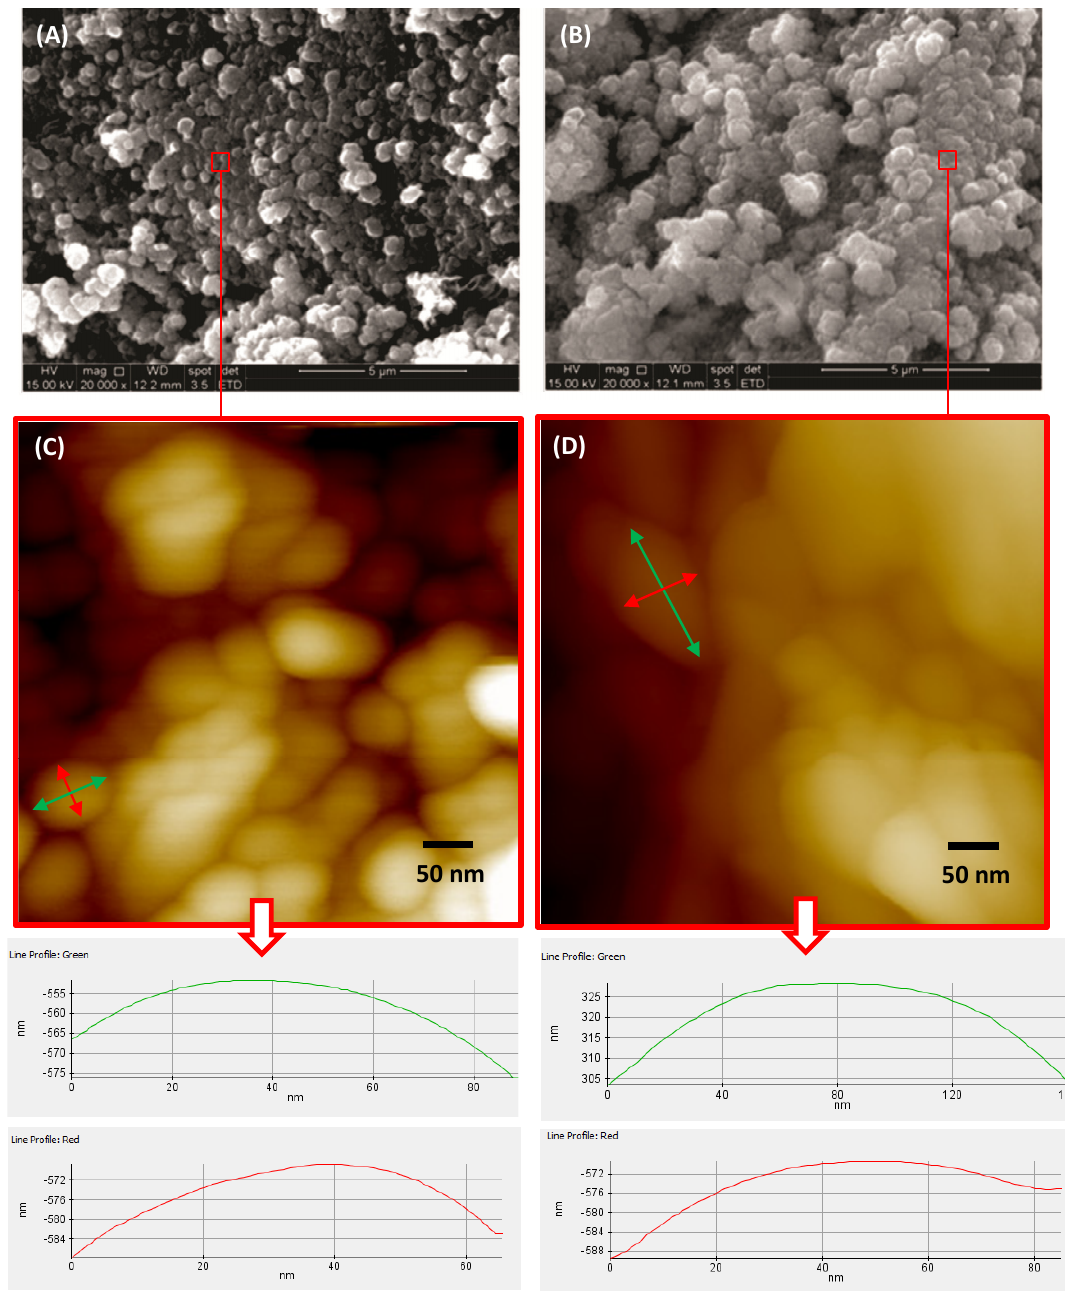
Figure 8. Typical SEM images of HA_110 ( A ) and HA_900 ( B ); AFM images of HA_110 ( C ) and HA_900 ( D ); arrows: AFM images with line profiles measuring the size of nanoparticles